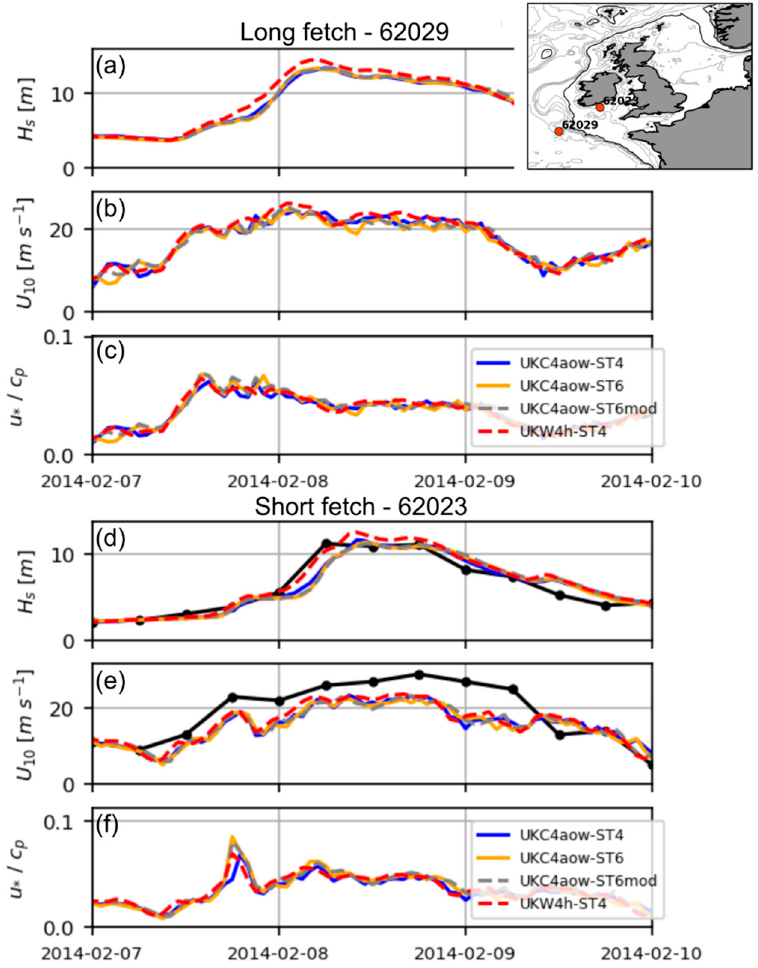
Figure 7. Timeseries of modelled ( a , d ) significant wave height ( H s ), ( b , e ) wind speed ( U 10 ), and ( c , f ) inverse wave age ( u ∗ / c p ) for long (62029) and short (62023) fetch locations during storm Ruth. Observed in-situ H s and U 10 are also presented in ( d ) and ( e ), respectively. The exact position for the specific locations is specified in the right corner inset.